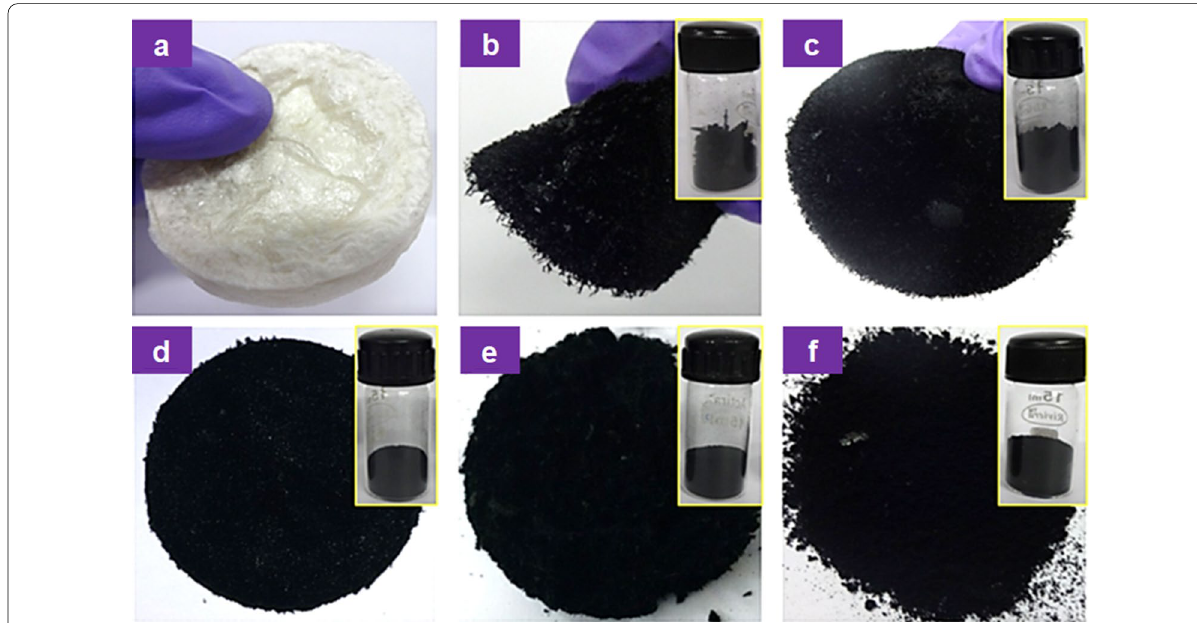
Fig. 3 Illustrations of C/PPy aerogels: a 100/0; b 100/25; c 100/50; d 100/75; e 100/100 and f 0/100. Insets showed the status of aerogels after physically grinding in a mortar and pestle [43] Copyright 2016 RSC